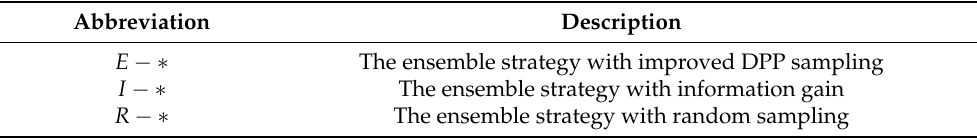
Table 2. Abbreviations and descriptions used in the experiments. Abbreviation Description E − ∗ The ensemble strategy with improved DPP sampling The ensemble strategy with information